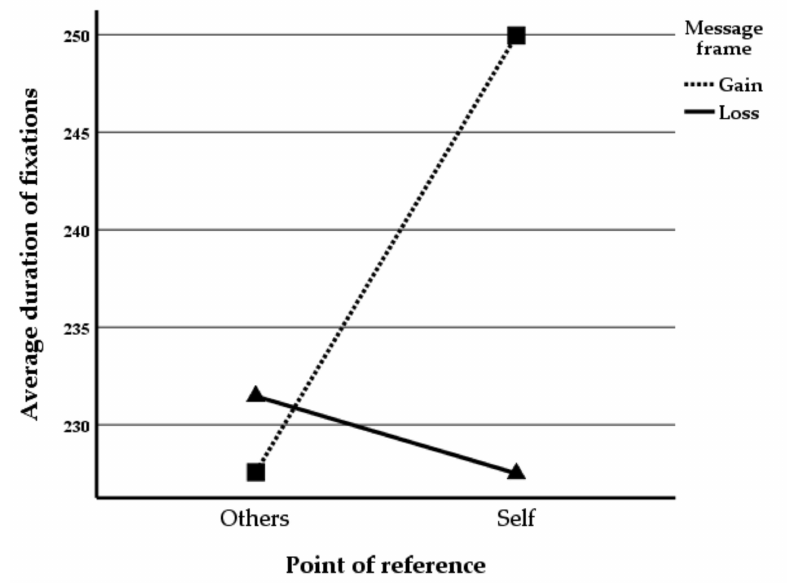
Figure 6. Interaction effect of message frame and reference point on the average duration of